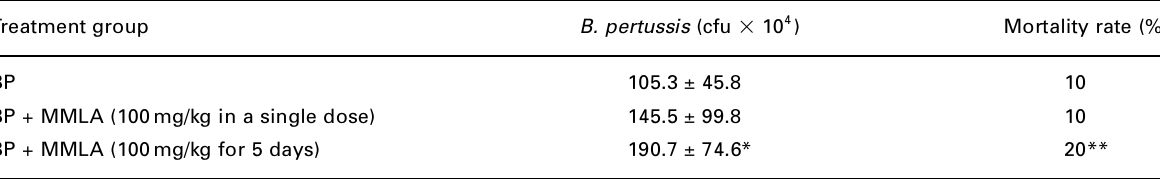
Table 2. Number of colony-forming units of B. pertussis in lungs of mice treated or not with MMLA, and mortality rate 10 days after they were infected intranasally with B. pertussis (10 5 cfu) Treatment